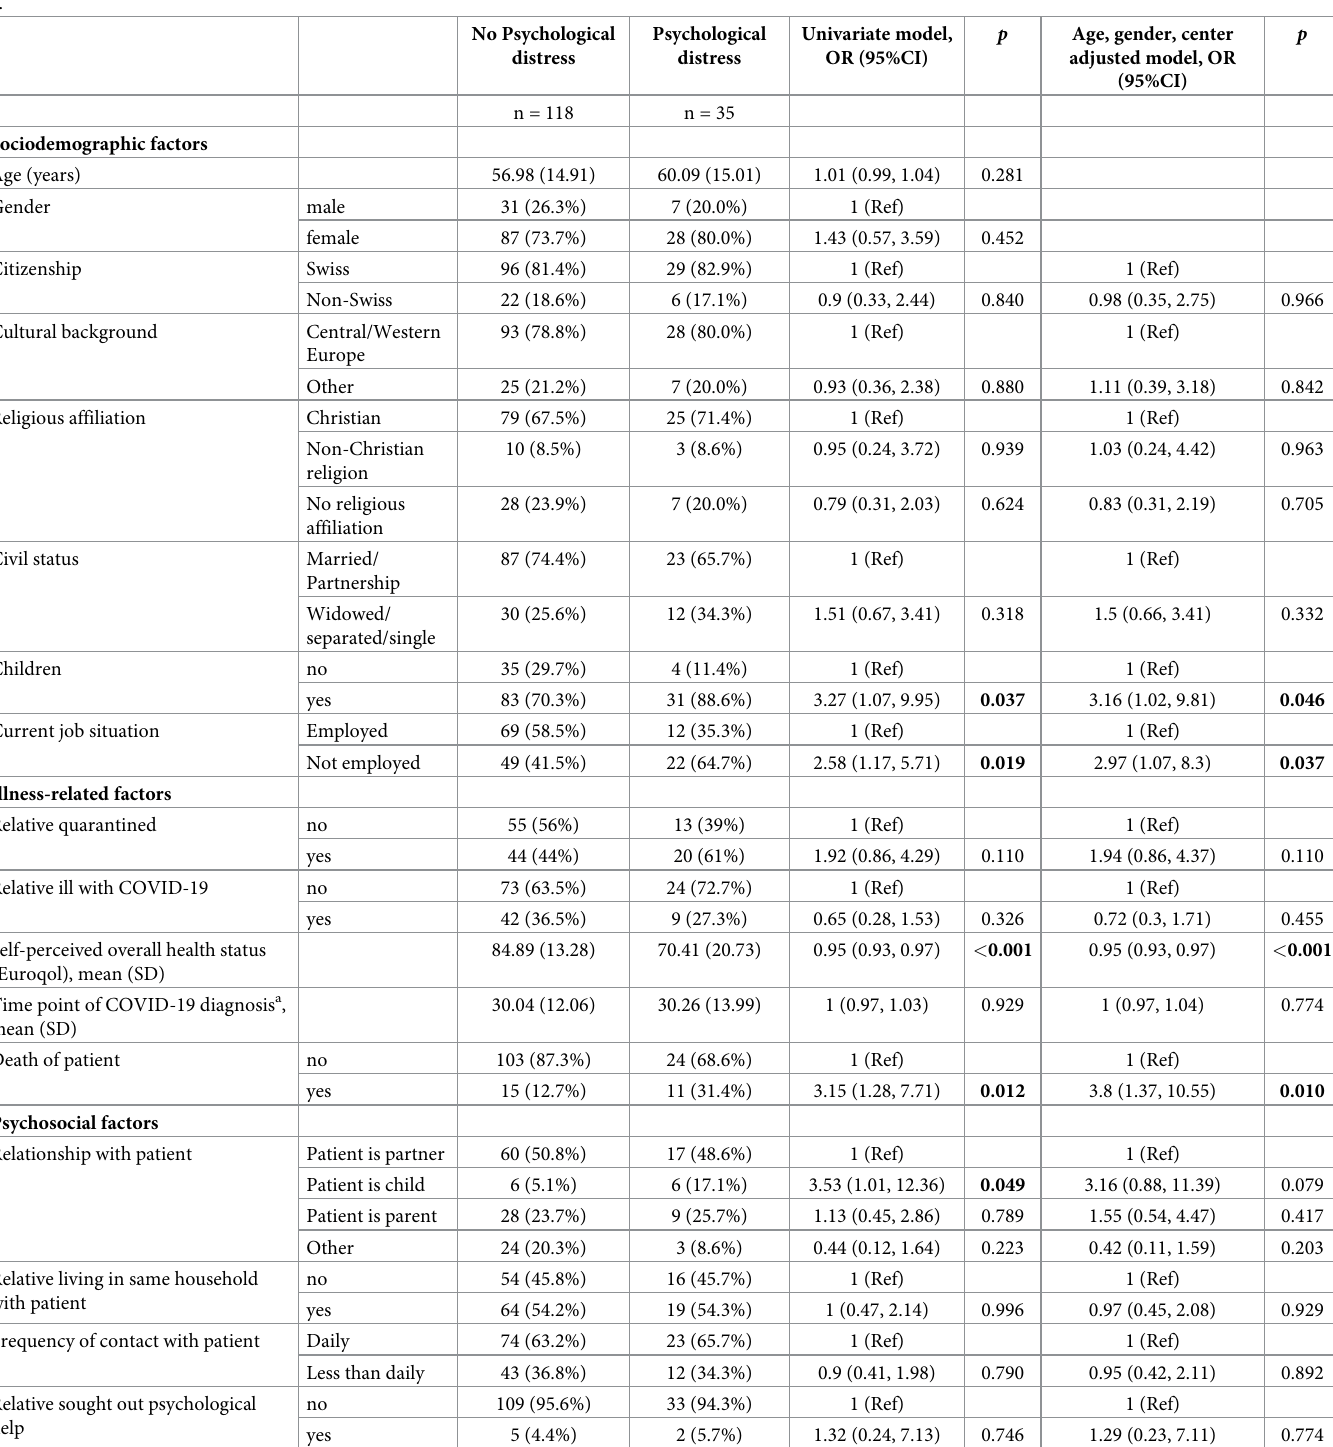
Table 3. Factors associated with psychological distress in